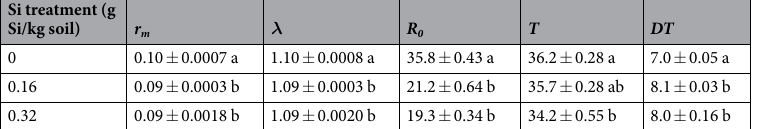
Table 2. Population parameters of Nilaparvata lugens feeding on rice plants amended with Si or not. Data are expressed as mean ± SE. Data in a column followed by different letters are significantly different (Tukey’s multiple range test, P = 0.05). The observation was made to three populations in each treatment. r m , intrinsic rate of increase (eggs per female per d); λ , finite rate of increase (population growth rate per d); R 0 ,